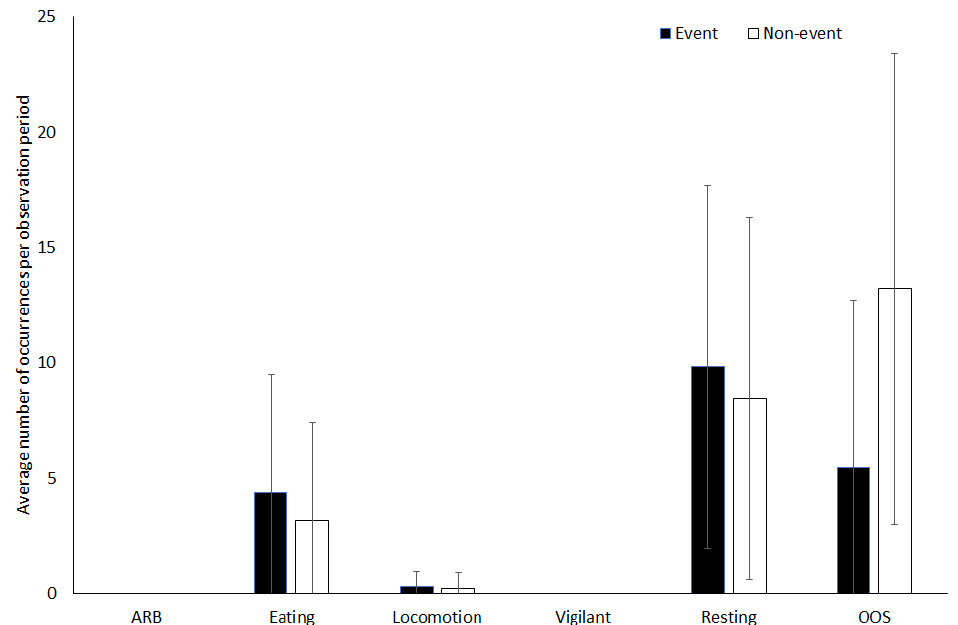
Figure 2. Activity budget data from 16:00 to 20:00 for four capybara (average number of occurrences of each behaviour within the group per observation period ± standard deviation) on event nights and non-event nights at Knowsley Safari. ARB: abnormal repetitive behaviour, OOS: out of sight of the observer.